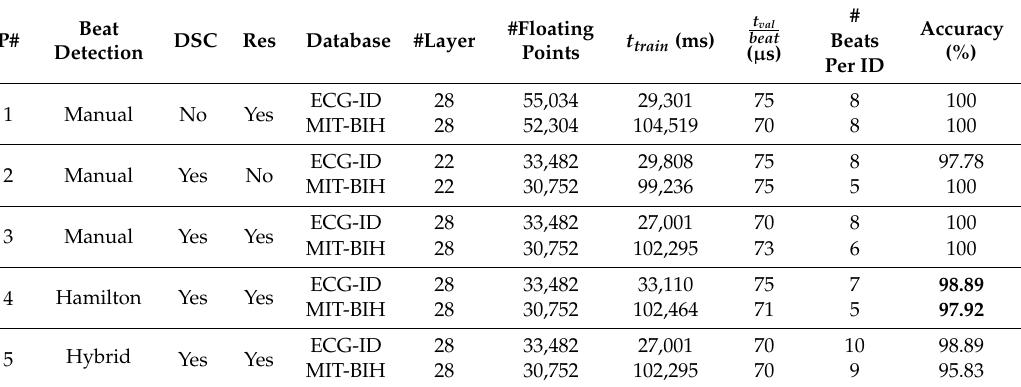
Table 4. Experimental Results for Various CNN Models.